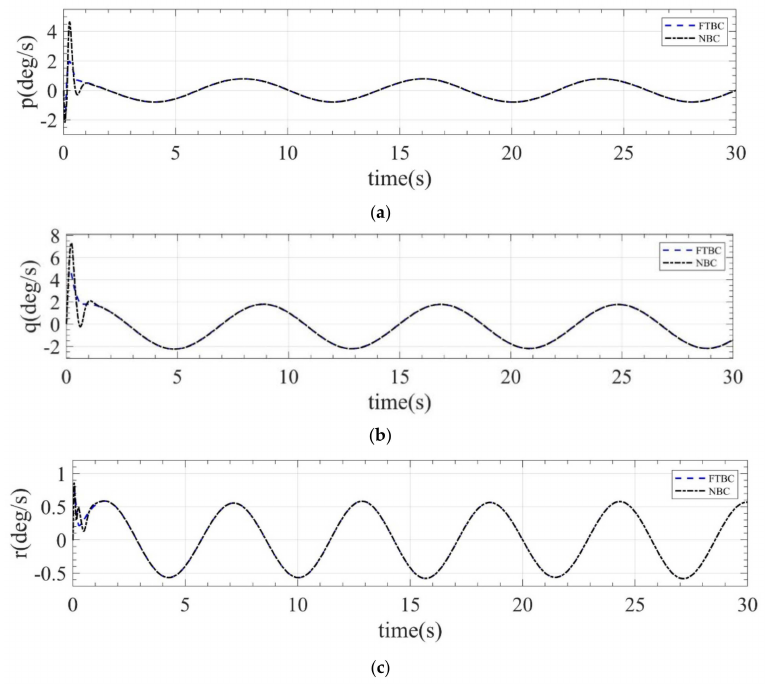
Figure 12. ( a ) Tracking curve of p, ( b ) tracking curve of q, and ( c ) tracking curve of